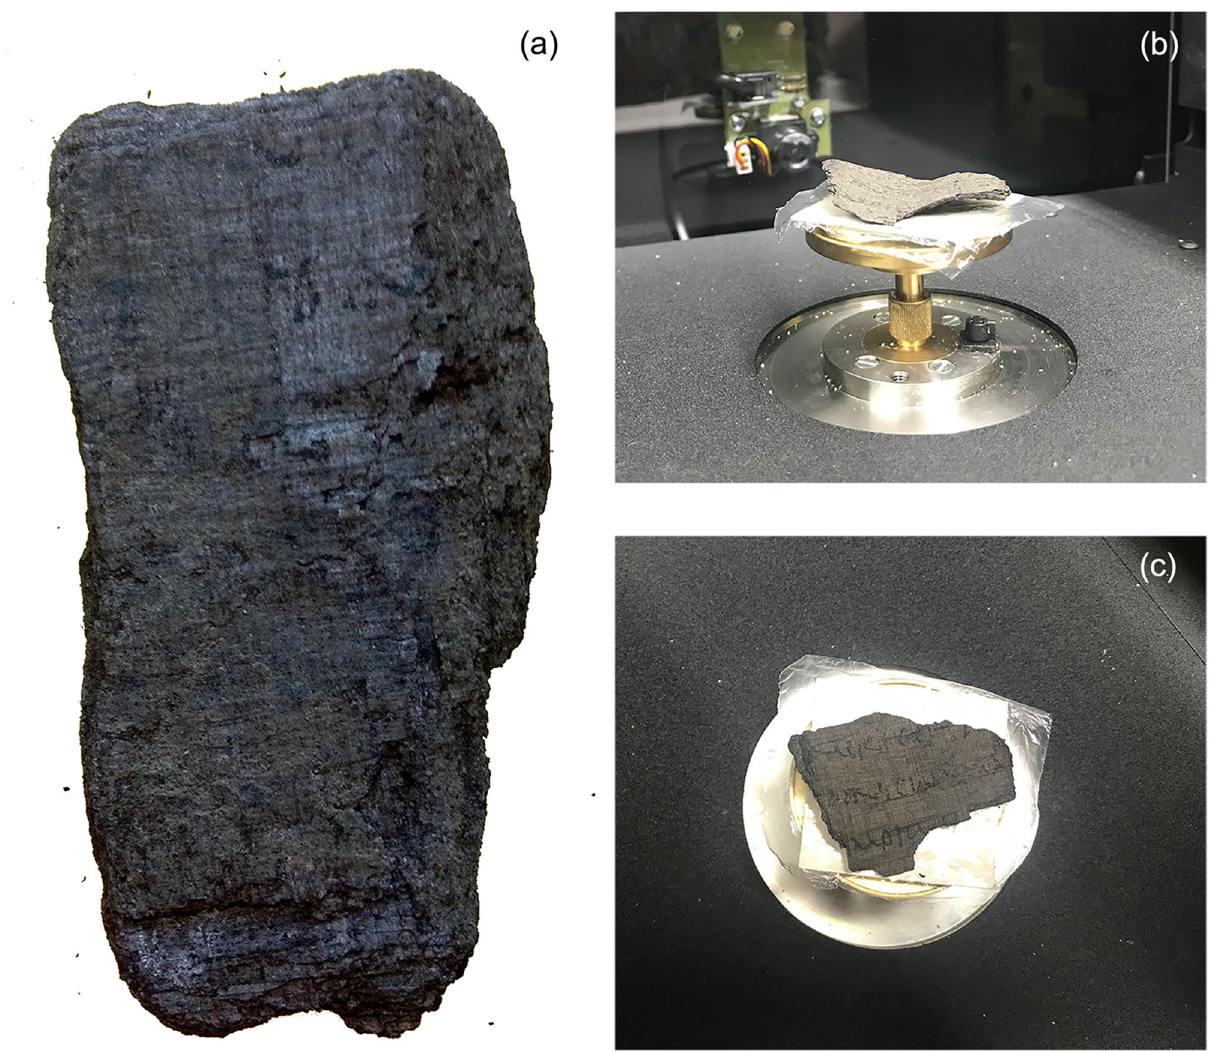
Figure 1. Photos of the papyrus fragments PHerc.1103 ( a ) and PHerc.110 ( b , c ). Image contrast and brightness were enhanced to better visualize the details visible to the naked eye on their external